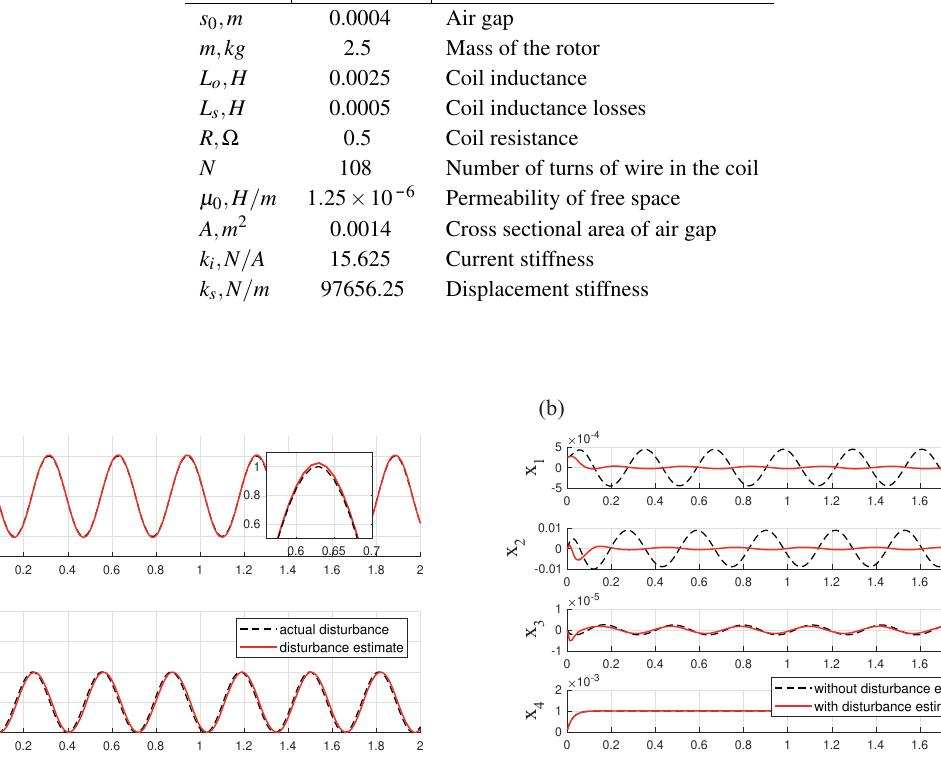
Figure 2. (a) Disturbance w , its time-derivative ˙ w and their estimate; (b) The state trajectories compared to the case when there is no disturbance estimation added to the control design.